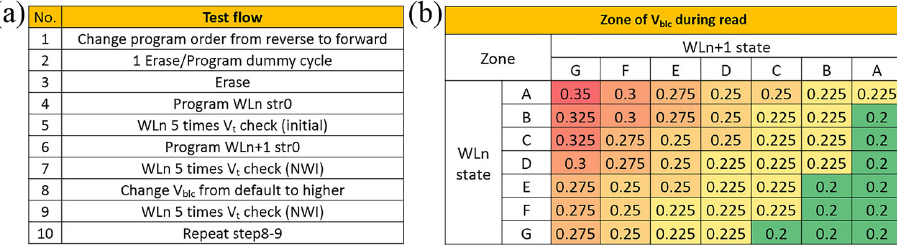
Figure 10. ( a ) Test flow of a 3D NAND chip for NWI. Program string (str0) randomly to collect all state combinations of WLn and WLn+1. ( b ) A set of V bl compensation for all states collected from chip tests. Similar to Table 2, each V bl is the value that minimizes the NWI of a specific state combination. To simplify operations, zones in the same color are victim situations with similar NWI, so these can share the same V blc .